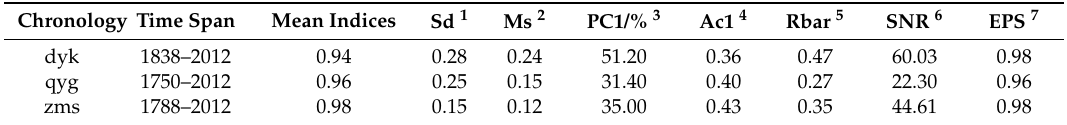
Table 2. Basic statistic of standard chronologies for Qinghai spruce from three sampling